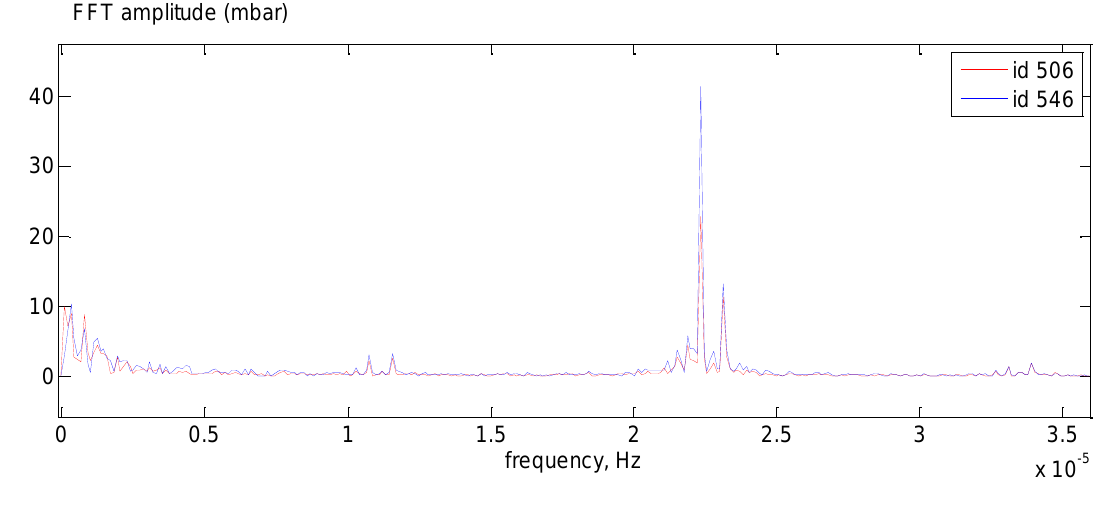
Figure 23. FFT spectra of #506 (red line) and #546 (blue line): zoomed in part of the Figure 22b.